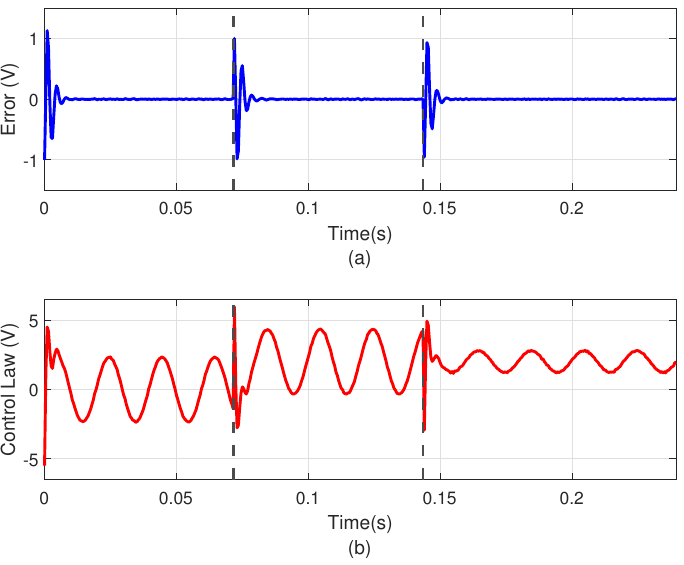
Figure 6. Experimental result for test 1, using p = 40, c = 20, r u = 0.07. ( a ) Error. ( b ) Control law.